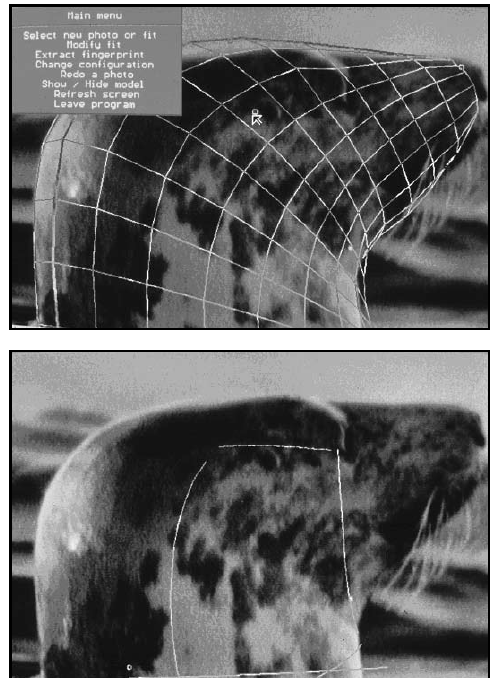
Fig. 3. The 3D surface model has been orientated, scaled and shaped so that the positions of the model nose, ear and eye coincide, as closely as possible, with those visible on the photograph and the margins of the model coincide with the margins of the head. The cursor shows the position of the ear on the model, which is just to the rear of its position on the photograph. A specified region of the model defines the region of the head and neck from which the pattern sample is to be scanned. The horizontal line near the bottom edge of that region prevents the scan from extending past the edge of the frame or below the